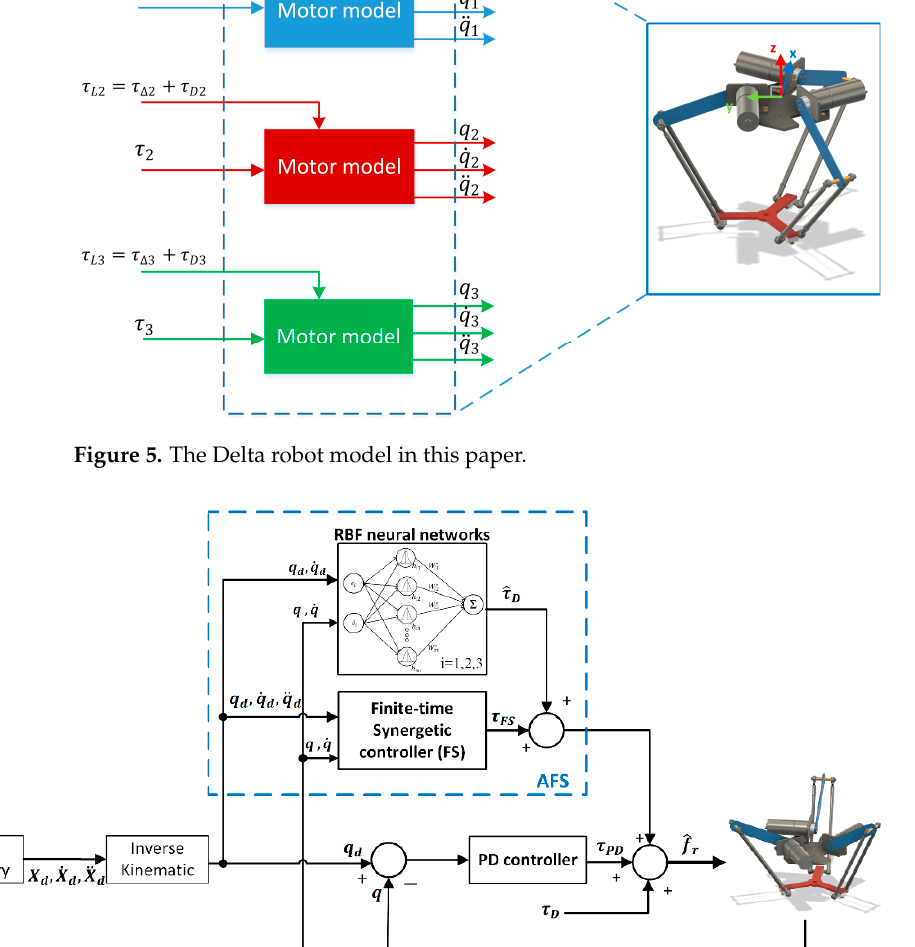
Figure 5. The Delta robot model in this paper. Figure 6. The proposed control scheme. Figure 6. The proposed control